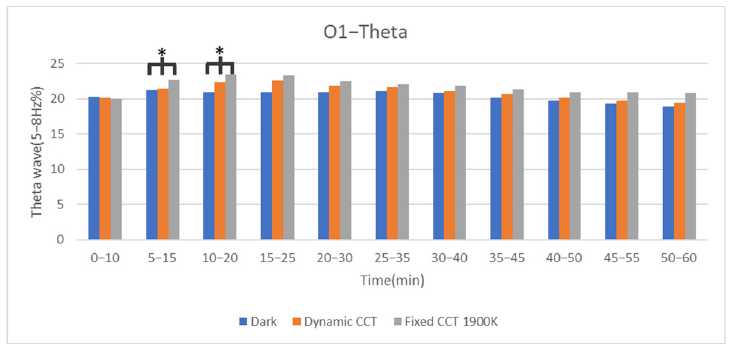
Figure 20. O1 θ wave analysis (* p < 0.05).